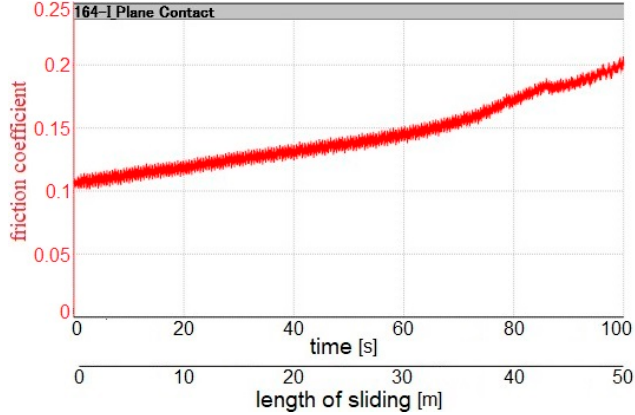
Figure 8. Dependence of the friction coefficient on the length of sliding for the 163-I sample surface.